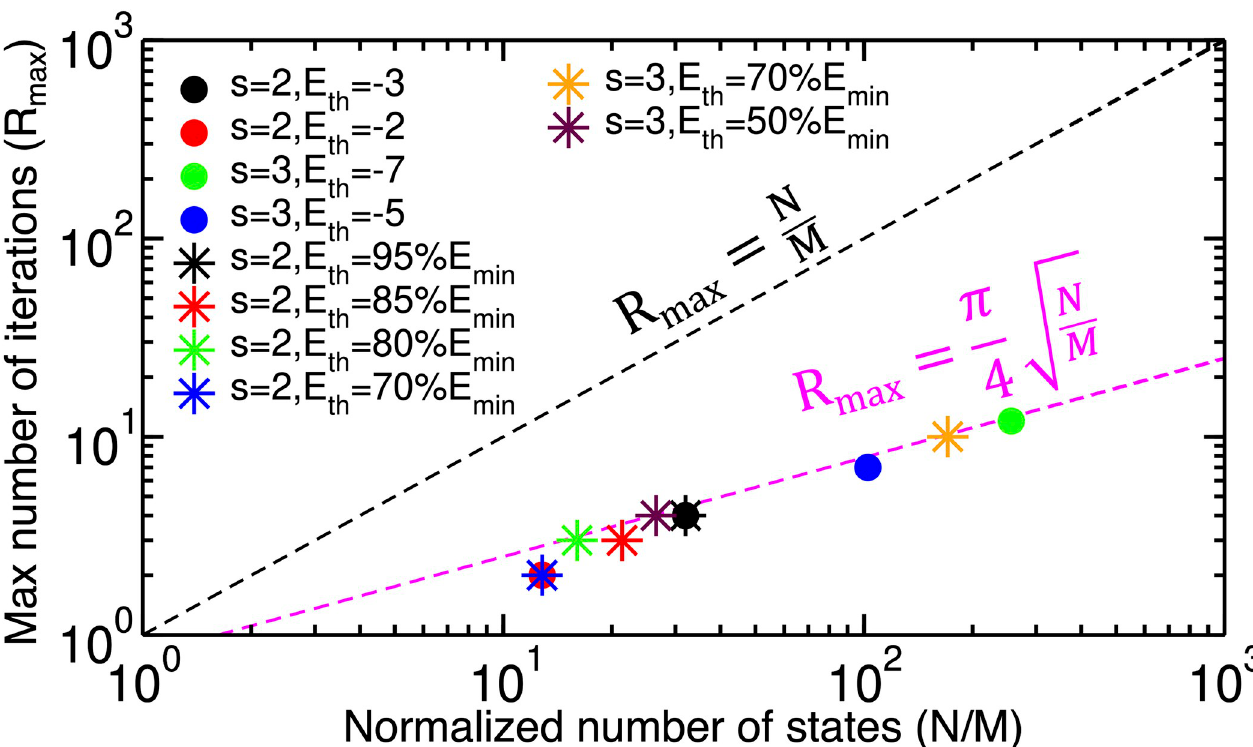
Fig 6. The maximum number of iterations ( R max ) values as a function of normalized number of states ( N/M ). The circles represent the data for the SP model and the stars are the data for the MR model. The magenta dashed line shows the R threshold of the classic